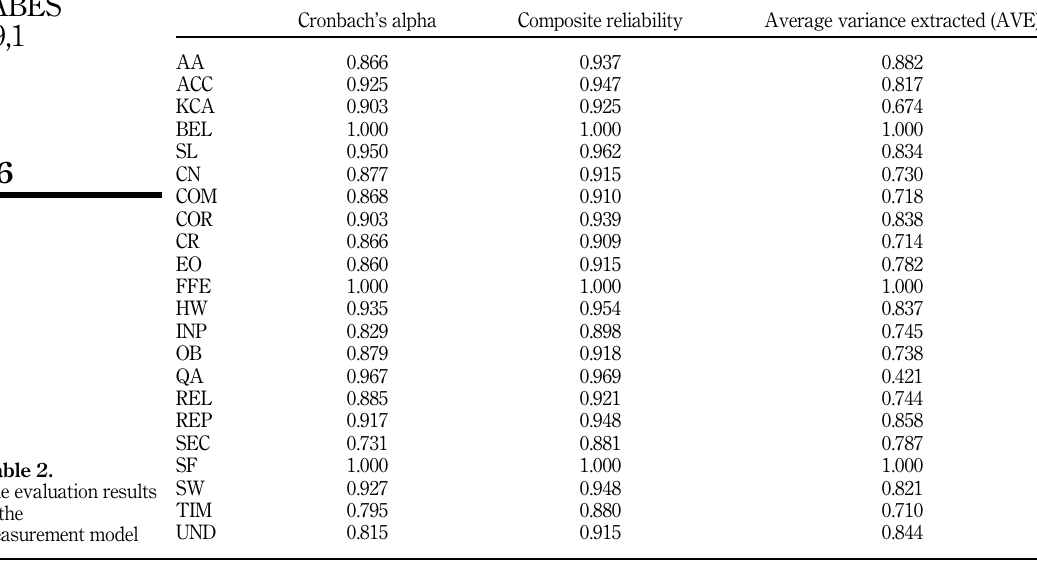
Table 2. The evaluation results of the measurement model